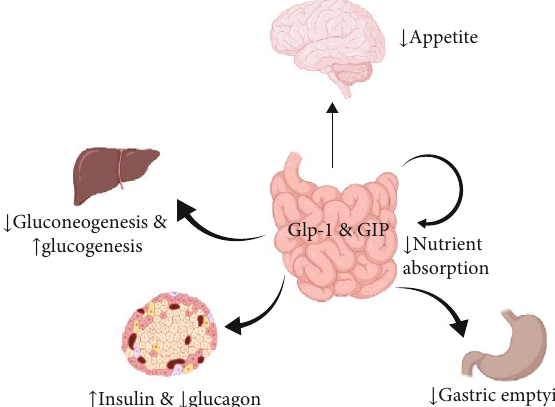
Figure 1: The major metabolic e ff ects of